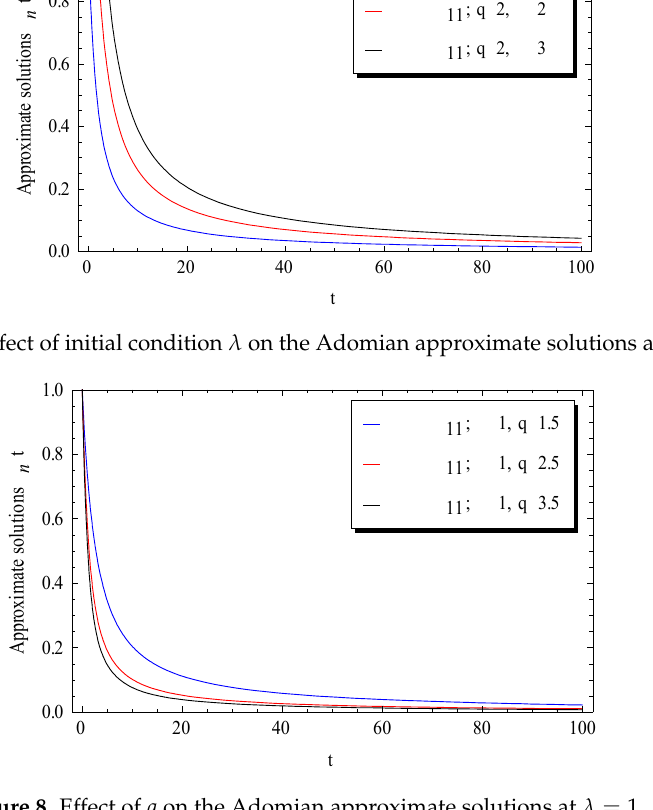
Figure 8. Effect of q on the Adomian approximate solutions at 1 =λ .